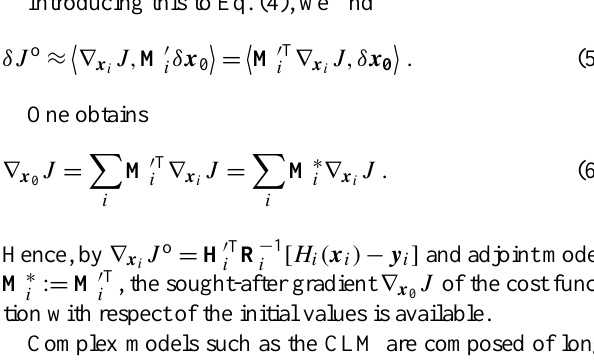
Table 1. Soil layers in the